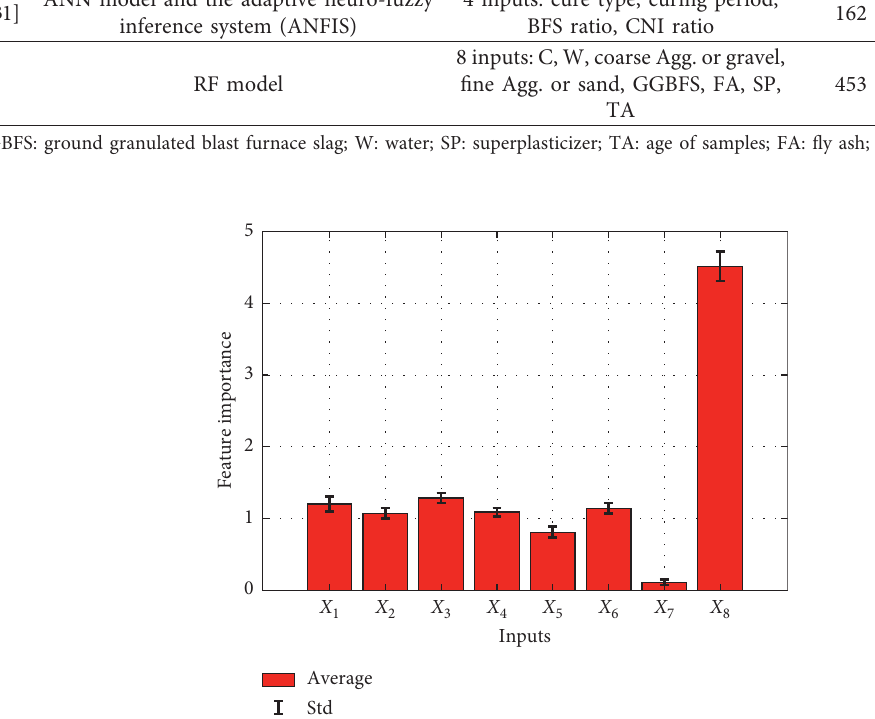
Figure 9: Feature importance over 500